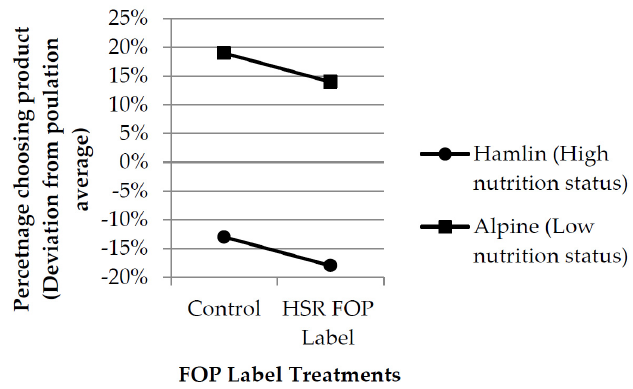
Figure 6. Graphical presentation of results.